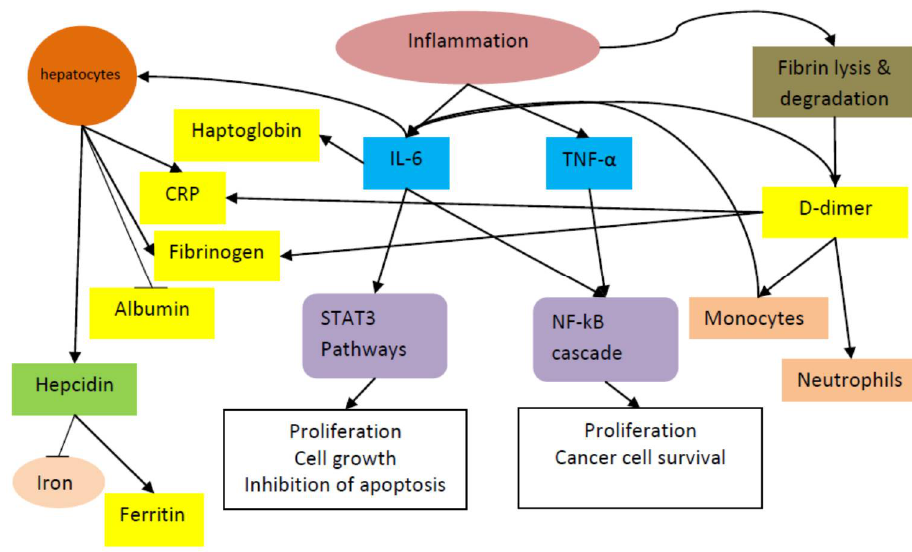
Figure 1. Inflammatory pathway involving inflammatory cytokines (shown in blue boxes) and acute-phase reactants (shown in yellow boxes). Only albumin is a negative acute-phase reactant, whose levels are reduced during inflammation (indicated by a bar instead of an arrow). STAT3: signal transducer and activator transcription 3; NF-κ β : nuclear factor κ β ; TNF-α: tumor necrosis factor-α; IL-6: interleukin-6; CRP: c-reactive protein.